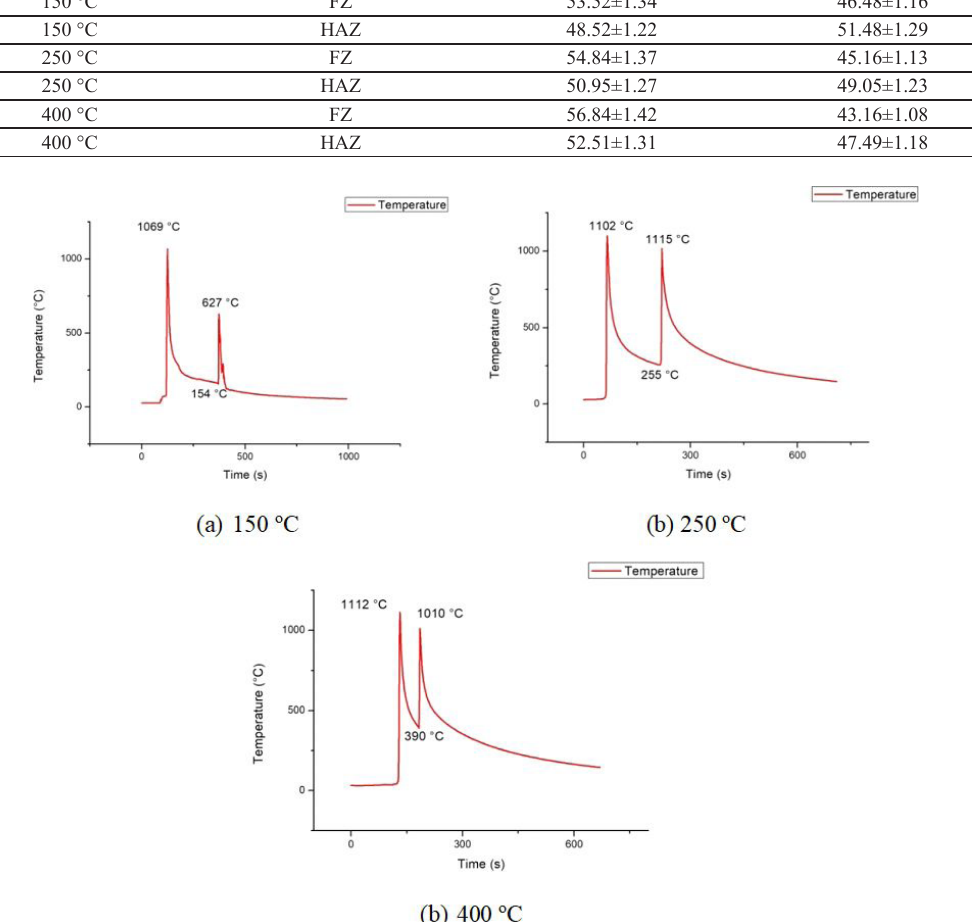
Figure 5. Thermal profiles indicating inter-pass temperatures and temperature evolutions during the welding procedures: a) 150 °C, b) 250 °C, and c) 400 °C.